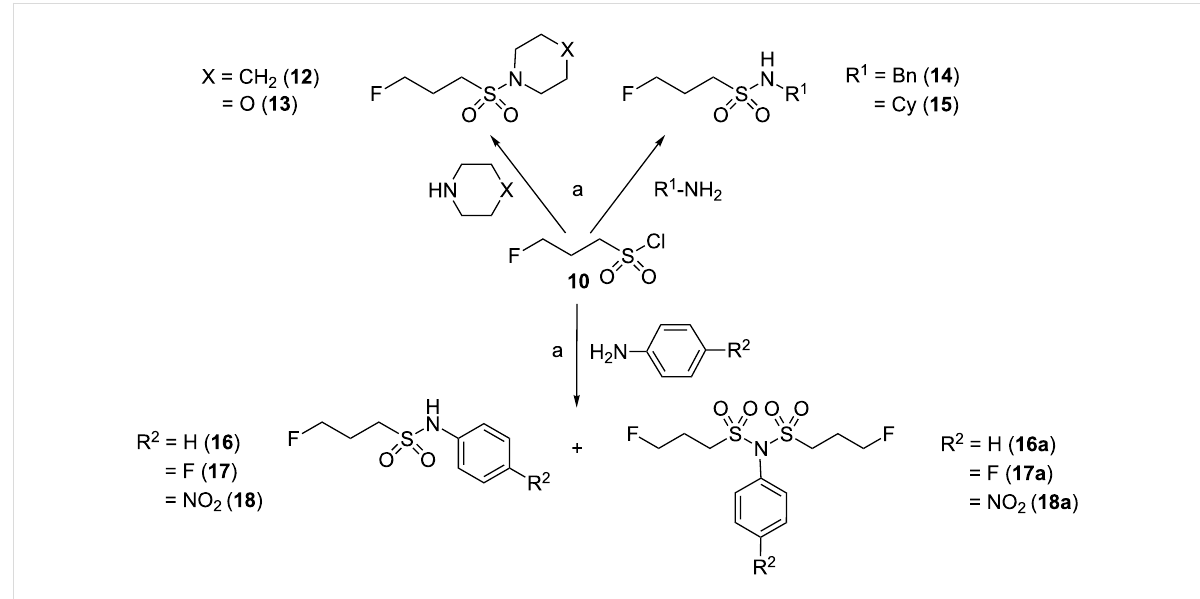
Scheme 3: Synthesis of 3-fluoropropanesulfonamides 12 – 18 . Reagents and conditions: (a) triethylamine (TEA), CH 2 Cl 2 , reflux (for 12 – 17 ) or pyri- dine,